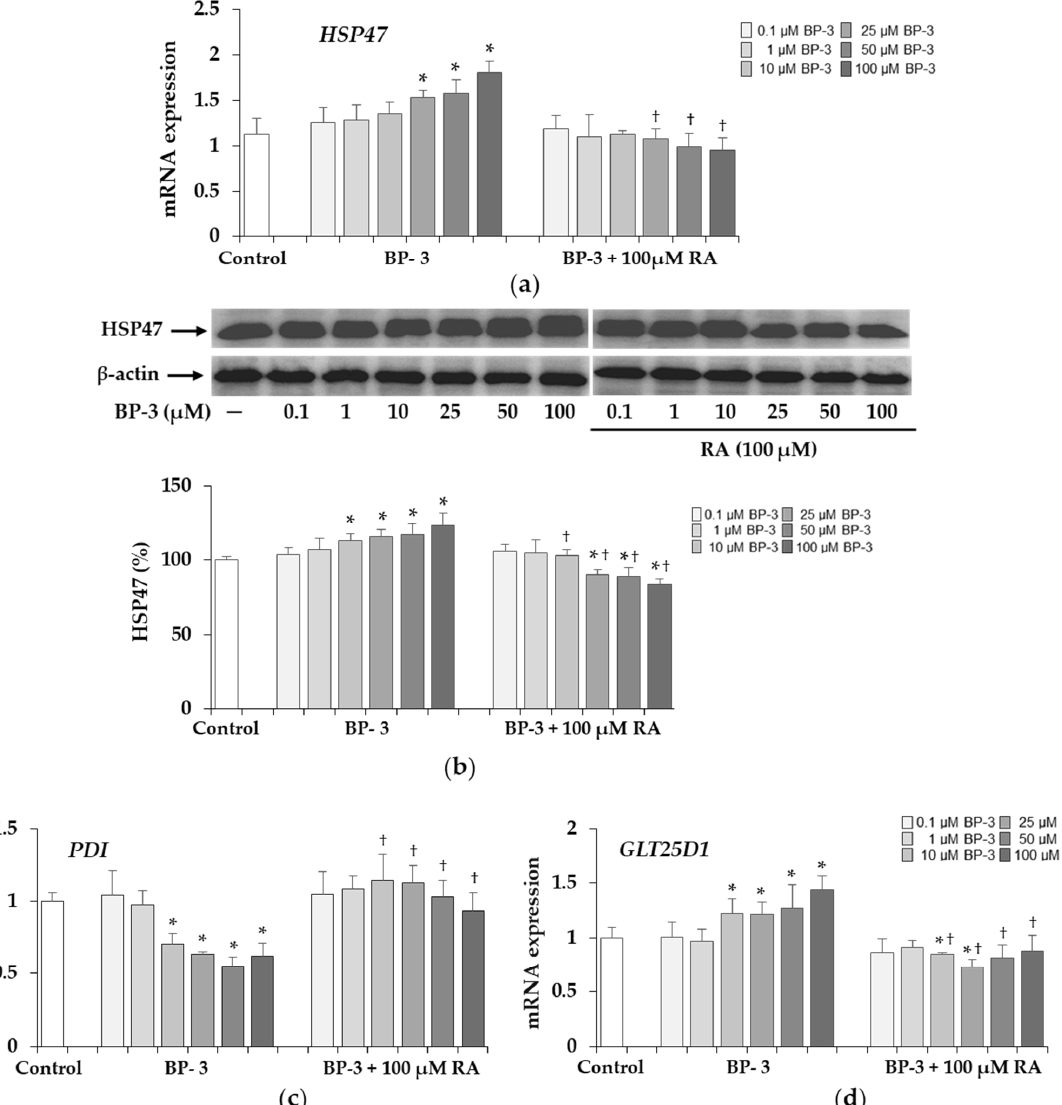
Figure 4. The influence of benzophenone-3 (BP-3) alone and in combination with rosmarinic acid (RA) on the expression of HSP47 at the mRNA ( a ) and protein ( b ) levels as well as on the expression of protein disulfide isomerase ( PDI ) ( c ), and glycosyltransferase 25 domains 1 ( GLT25D1 ) ( d ) transcripts in fibroblasts. The expression of HSP47 , PDI , and GLT25D1 genes was assayed by real-time PCR, values represent the mean ± SD of three experiments. Representative gels of Western blotting (β-actin was used as cell protein loading control); densitometry values represent the mean ± SD of three experiments; the data are expressed as a percentage of the control sample assumed as 100% ( b ); * p < 0.05 vs. control (untreated cells); † p < 0.05 vs. respective samples treated with BP-3 alone.